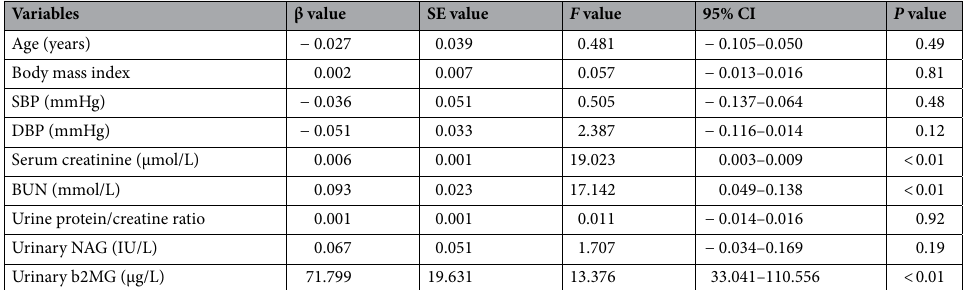
Table 3. Multivariate analysis of factors associated with the rate of change in estimated glomerular filtration rate. SE standard error, CI confidential interval, SBP systolic blood pressure, DBP diastolic blood pressure,